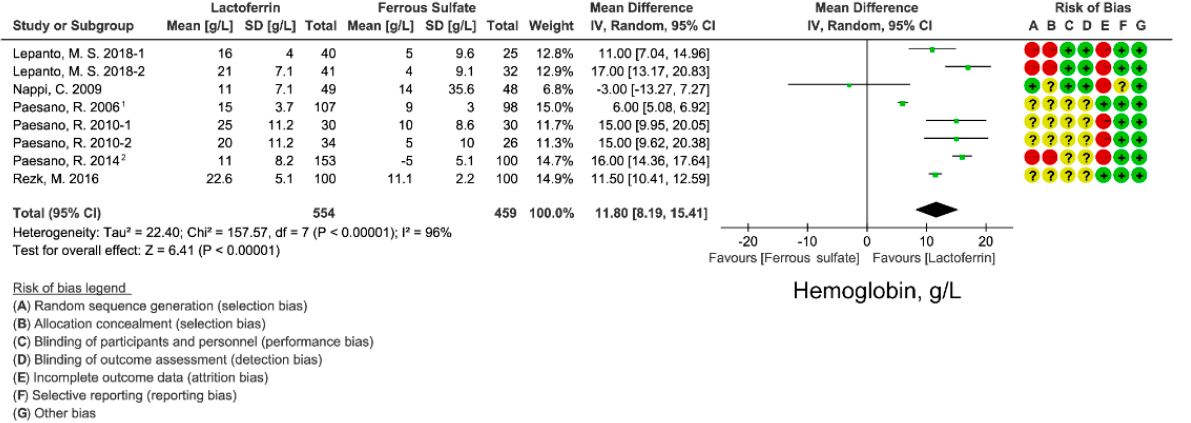
Figure 4. Effect of lactoferrin and ferrous sulfate on hemoglobin concentrations. 1, converted from median and minimum-maximum range. 2. Mean and SD were estimated from histogram. Risk of bias legend: A = random sequence generation (selection bias); B = allocation concealment (selection bias); C = blinding of participants and personnel (performance bias); D = blinding of outcome assessment (detection bias); E = incomplete outcome data (attrition bias); F = selective reporting (reporting bias); G = other bias. Data expressed as weighted mean difference (95% CI). IV, inverse